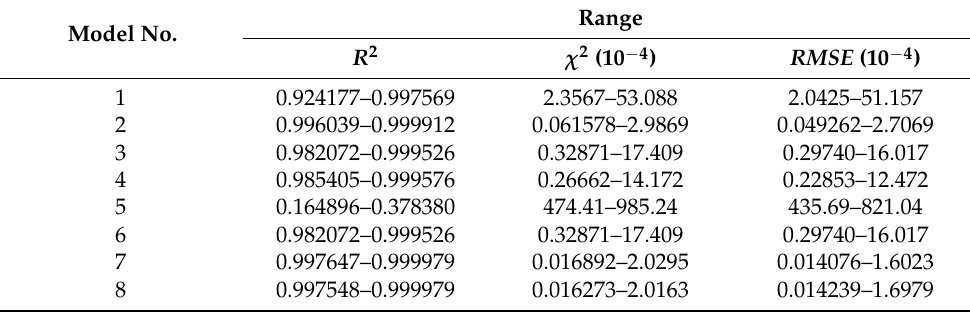
Table 10. Comparison of evaluation indicators.